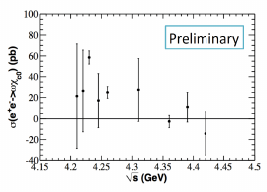
Figure 4. The Born cross section of e + e − → π + π − h c from BESIII experiment, and those of e + e − → π + π − J /ψ from Belle experiment.